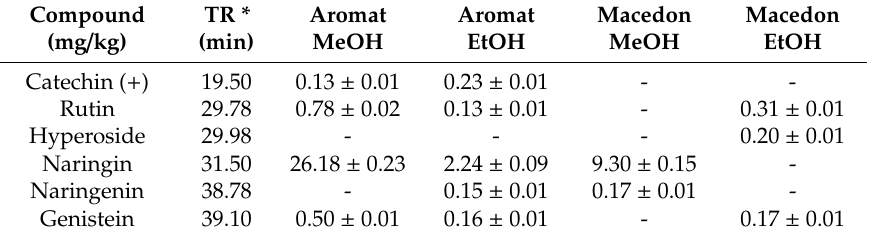
Figure 8. HPLC—DAD chromatograms of the samples: ( a ) “Aromat de Buzau” -methanolic extract (1—catechin, 2—rutin, 3—naringin, 4—genistein), ( b ) “Aromat de Buzau” ethanolic extract (1—catechin, 2—rutin, 3—naringin, 4—naringenin, 5—genistein), ( c ) “Macedon” methanolic extract (1—naringin, 2—naringenin), and ( d ) “Macedon” ethanolic extract (1—rutin, 2—hyperoside, 3—genistein) with detection at 300 nm. Table 1. HPLC-DAD identification and quantification of flavonoids from basil extracts.